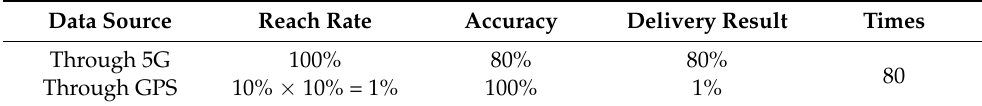
Table 17. Comparison of delivery effectiveness on night market tourists.